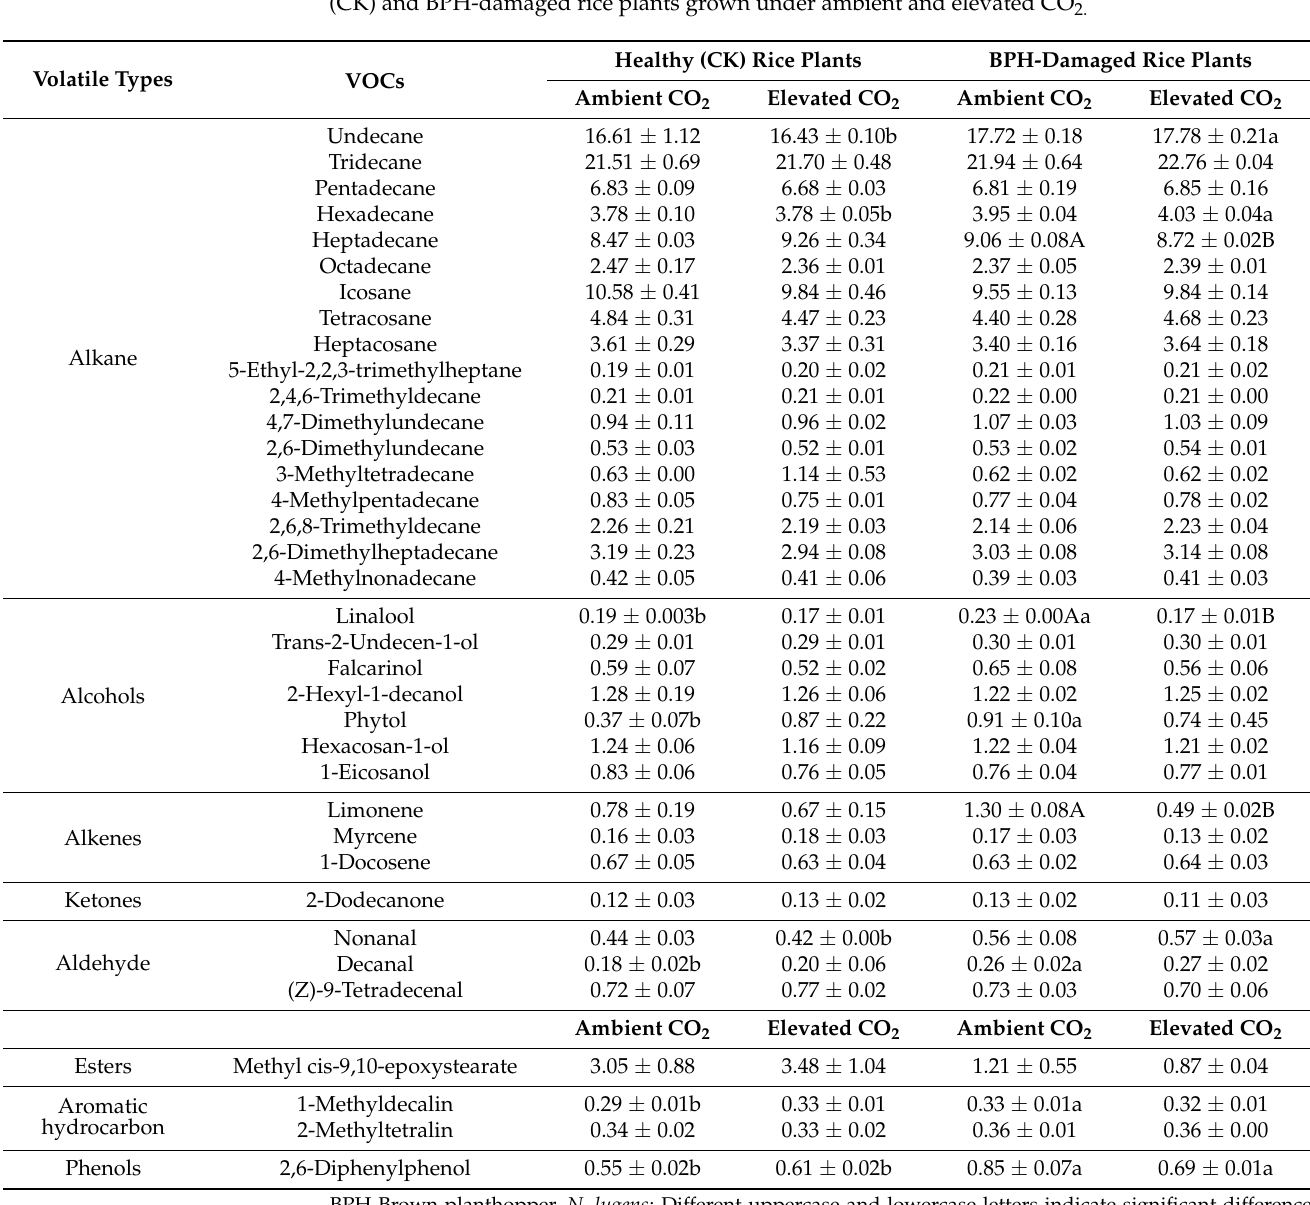
Table 4. Composition and percentage (%) of the volatile organic compounds (VOCs) from the healthy (CK) and BPH-damaged rice plants grown under ambient and elevated CO